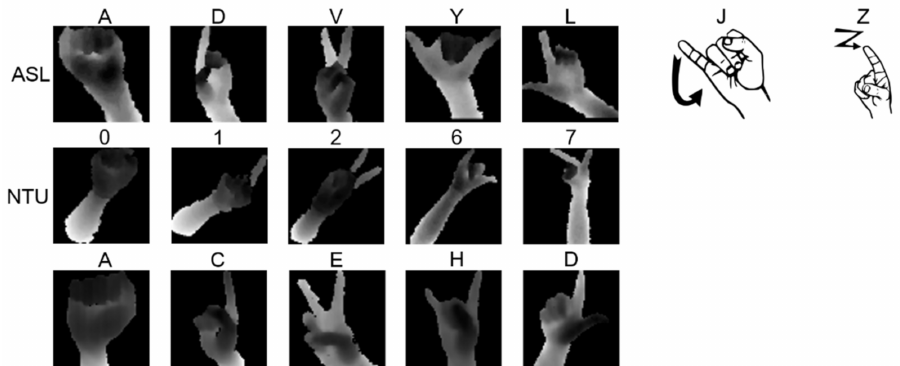
Figure 5. Samples from ASL, NTU, and OUHANDS datasets. The letter on the top of each panel represents the gesture label of the dataset. Each column represents the gestures that share similar hand shapes but different labels across three datasets. The letters j and z were excluded due to their dynamic